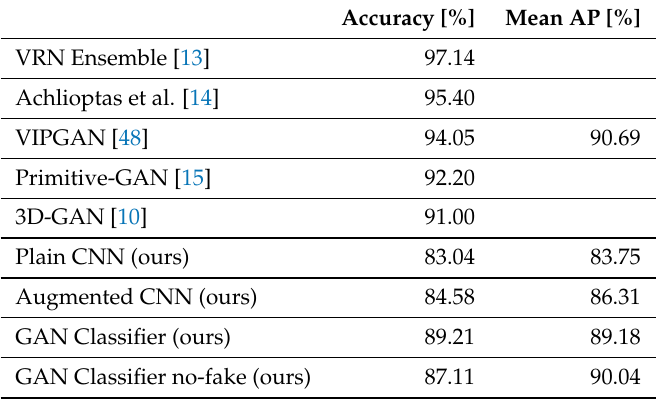
Table 1. Comparison of classification accuracy and mean average precision (Mean AP) score of generative modelling-based classifier architectures validated on the ModelNet10 dataset [19]. These are the results from the public ModelNet leaderboard. Some of the models do not publish their Mean AP.